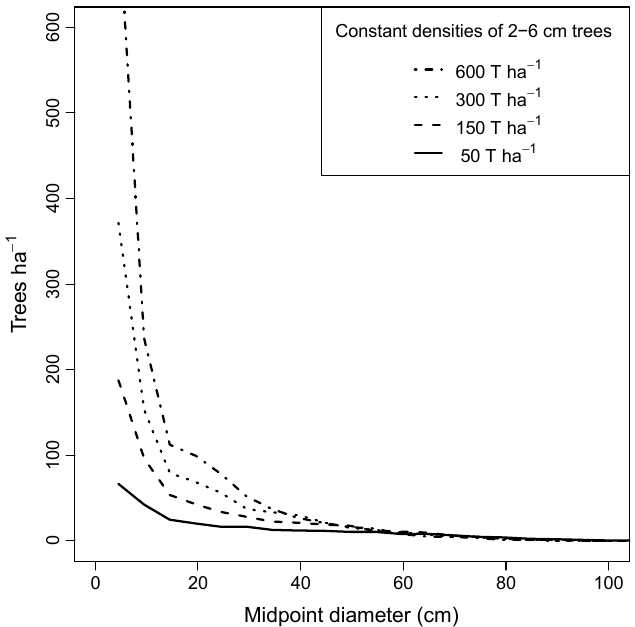
Figure 8. Predicted diameter distributions in simulation year 1000 of pure maple stands in which the specified densities of 2–6 cm DBH saplings were maintained at constant levels (Group 2a simulations). Data shown are the mean of 20 replicates. Data are grouped by 5 cm classes in this case in order to match q ‐ ratios in the forestry literature.